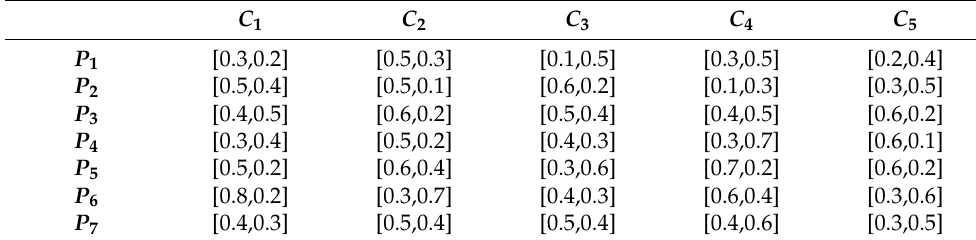
Table 3. Original evaluation criteria information matrix at the moment t 2 .